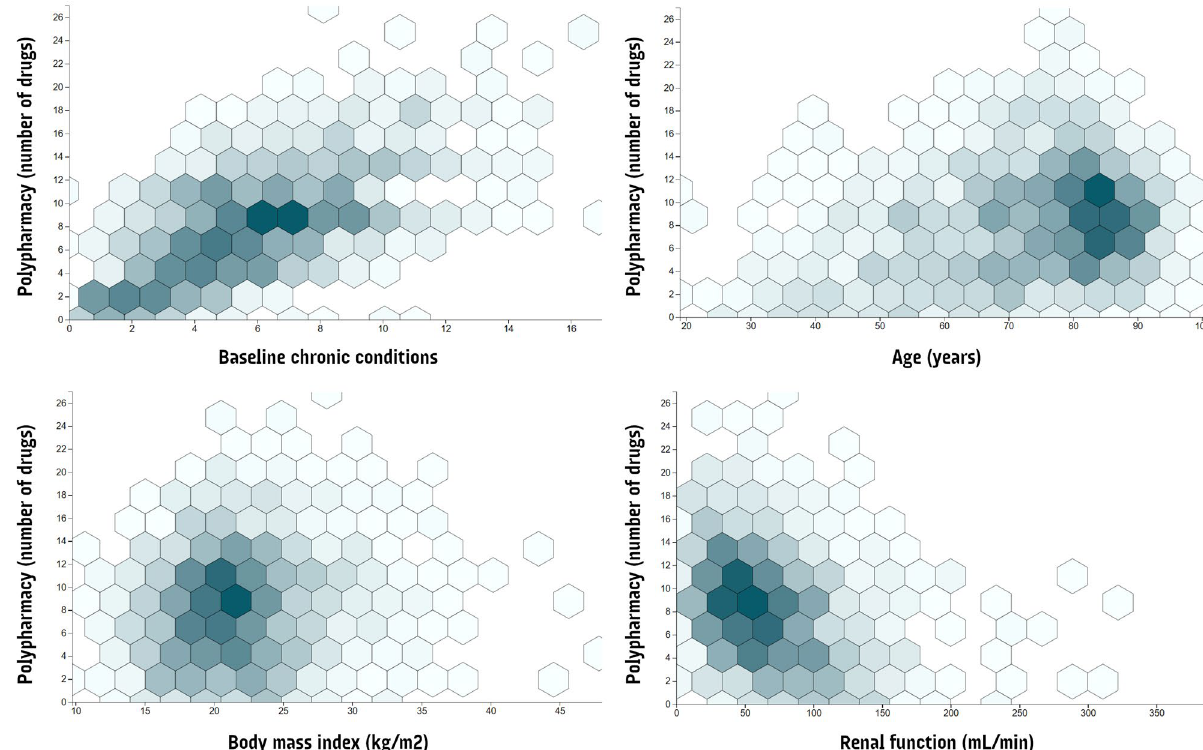
Figure 2. Hexagonal binning chart of distribution of Polypharmacy across selected variables. The graph visually cluster the most populated areas on a scatterplot (colour intensity increases with frequency). Interventions at the prescriber Problems Causes level Interventions at the drug level Outcome of